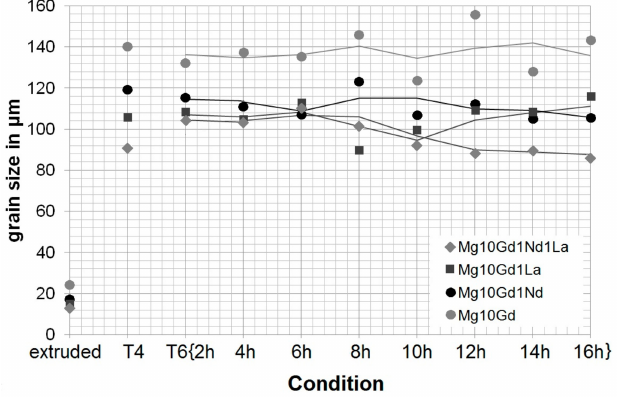
Figure 2. Effect of adding Nd or/and La on grain size development during precipitation